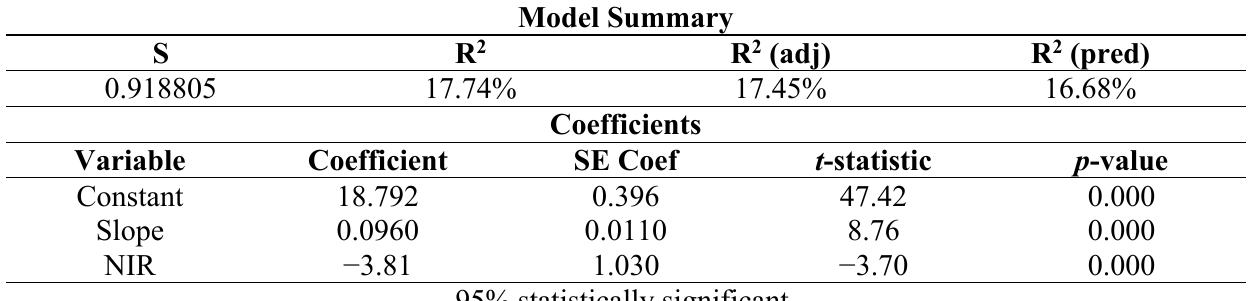
Table 9. Night time regression analysis results by NIR